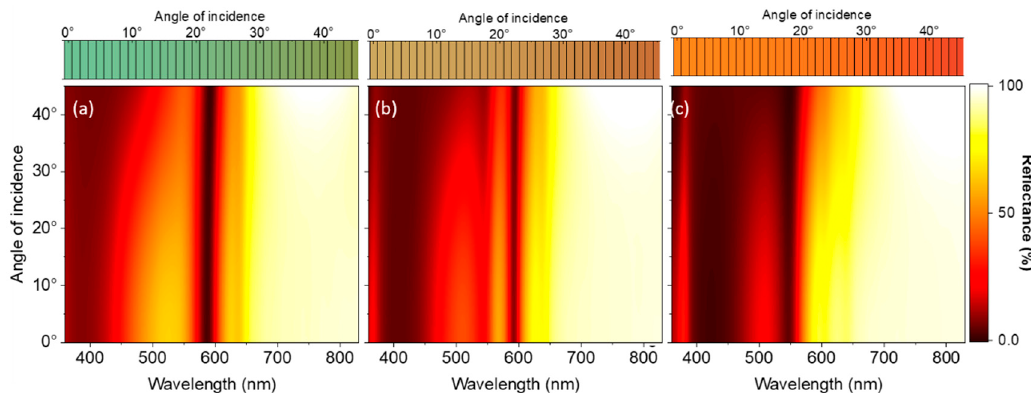
Figure 4. Simulated reflectance spectra as function of the illumination angle for hybrid structures with polymer thicknesses of ( a ) 100 nm, ( b ) 120 nm and ( c ) 140 nm. The excitation was p-polarized. The calculated generated colours (sRGB) corresponding to the individual illumination angles are displayed above the simulated reflectance.